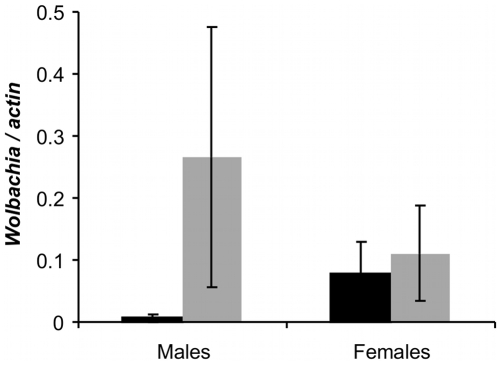
Mean Wolbachia density in wild specimens from La Réunion Island.Each DNA was quantified in triplicate and the average density was calculated for each specimen. Mean density in the population is reported for each sex and is depicted in black for wAlbA and grey for wAlbB. Standard error is calculated on the mean of all average densities (males N = 15, females N = 10).